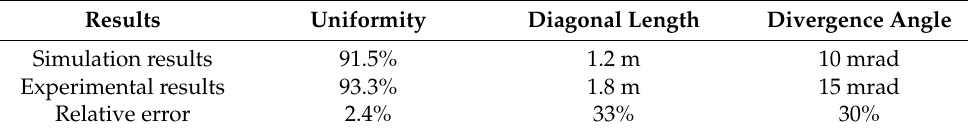
Table 4. Experiment results compared with simulation results (120